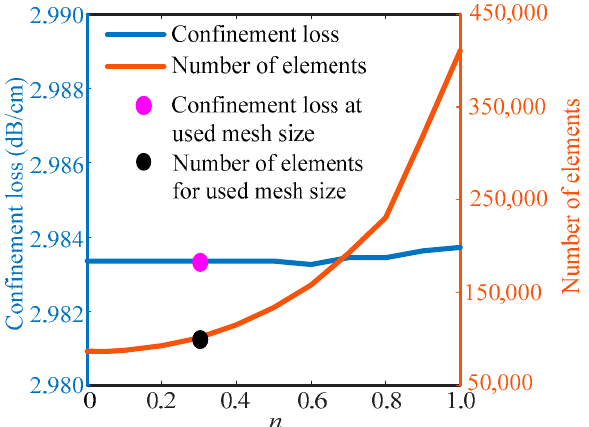
Figure 2. Confinement loss and maximum number of elements as a function of mesh size parameter. Asymmetrical structure of the PCF results in the existence of birefringence. Therefore, light propagating inside the fiber shows x -and y -polarizations of the fundamental and SPP modes, as shown in Figure 3a–d.The field distribution of these modes is shown for the analyte RI = 1.43 at the resonant wavelengths. Figure 3e demonstrates the RI and confinement loss as a function of wavelength for the fundamental and the SPP modes for both x - and y -polarizations. It is seen that resonance occurs at the phase-matching wavelength that results in maximum energy transfer from the fundamental modes to the SPP modes, and confinement loss becomes maximum for both polarized lights. For example, phase matching or resonant wavelengths are 1250 nm for x -polarization and 1080 nm for y -polarization. Additionally, the peak confinement losses at the resonant wavelengths are 97.04 and 12.89 dB/cm for x -and y -polarizations, respectively. As the operating wavelength, red/blue shifts far from the resonant wavelength, and the confinement loss approaches its tail from the peak loss. From Figure 3, it is noted that at the resonant condition, energy transmission increases significantly from the core to the SP for the x -polarized field compared with the y -polarized field because of efficient excitation of metal electrons by the evanescent wave. As a result, we consider sensor optical characteristics for x